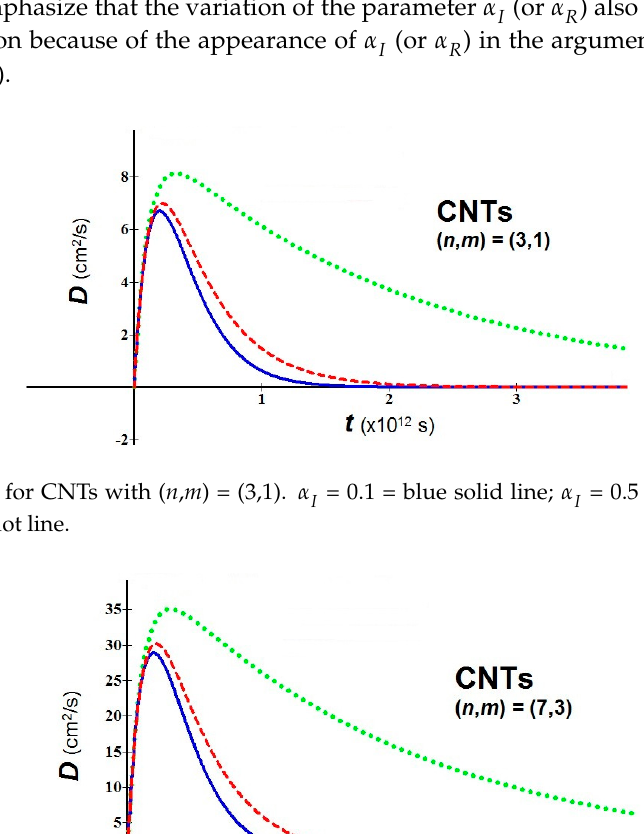
Figure 3. D vs. t for CNTs with ( n , m ) = (7,3). I α = 0.1 = blue solid line; I α = 0.5 = red dashed line; α = 0.9 = green dot line.